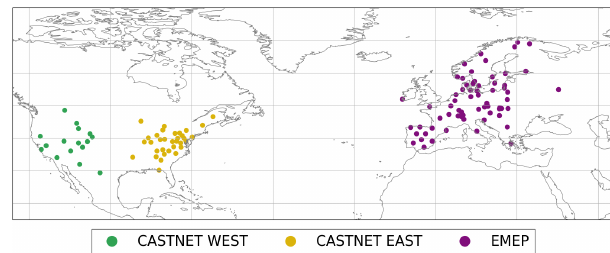
Figure 1. Map of the locations of the CASTNet and EMEP mea- surement sites used in this